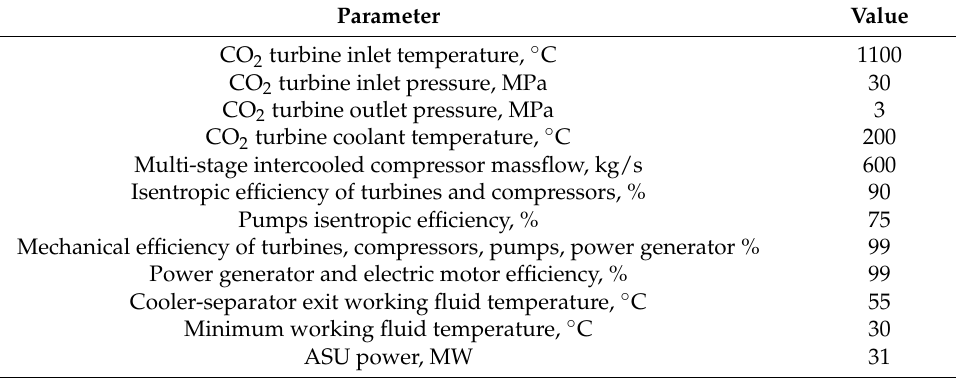
Table 1. Parameters of the Allam cycle heat balance